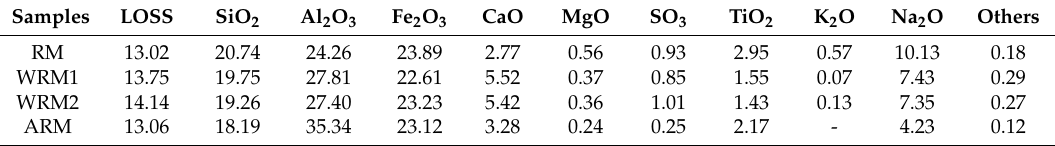
Table 1. The composition of RM, WRM1, WRM2 and ARM (wt%). RM: red mud; WRM n :